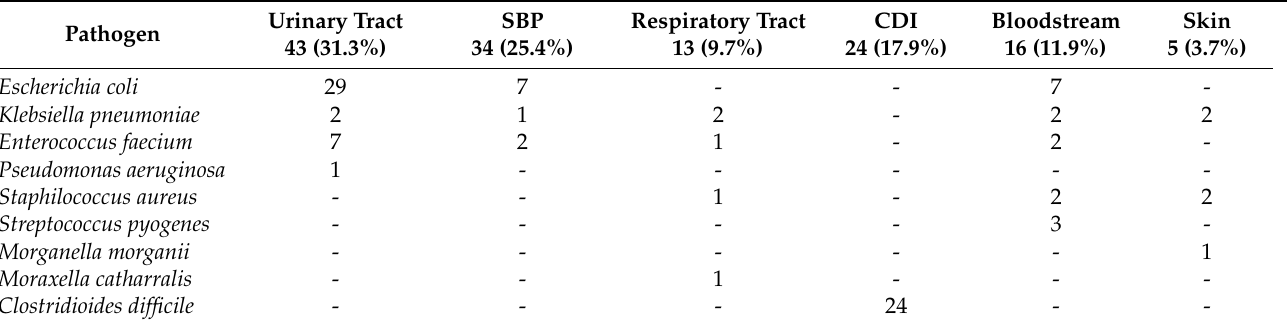
Table 2. Bacteria identified in the study